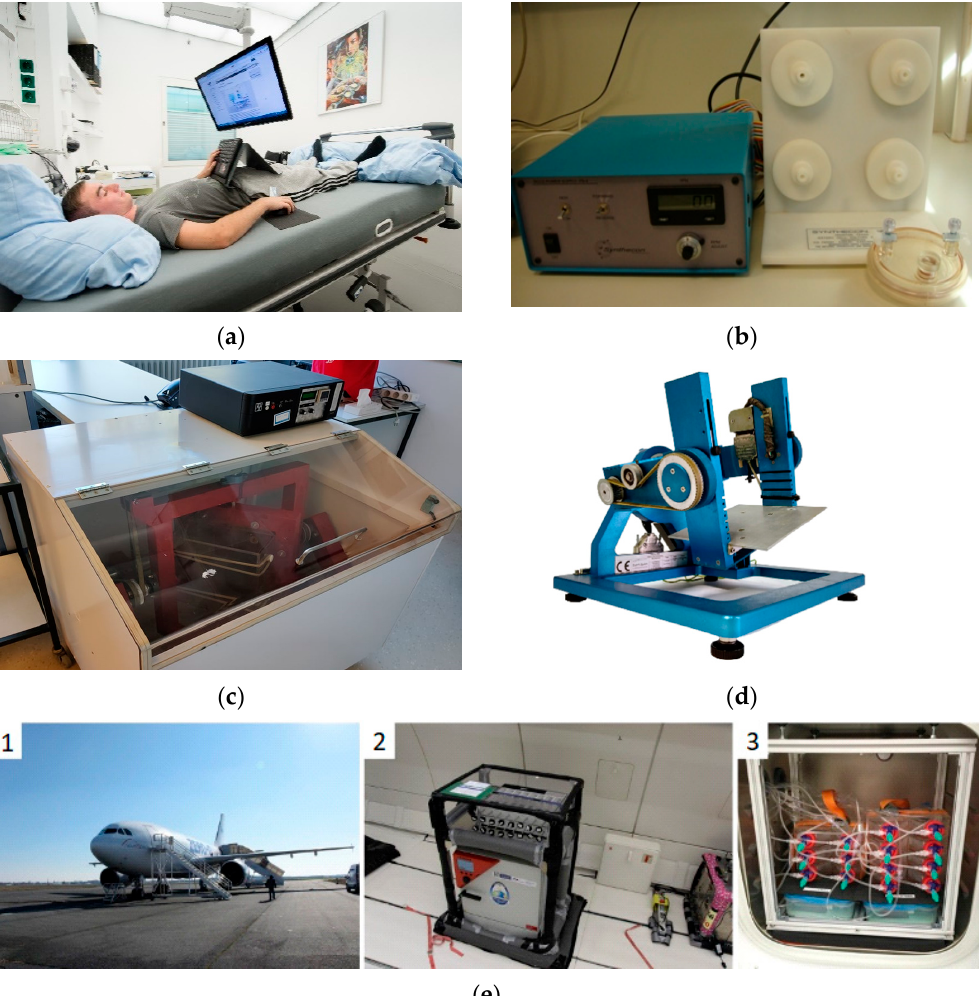
Figure 1. An overview of microgravity analogues. ( a ) The head-down bed rest experiment configura- tion (taken from the National Aeronautics and Space Administration (NASA) and Deutsches Zentrum für Luft-und Raumfahrt (DLR), CC BY-NC-ND 3.0 [56]); ( b ) a commercially available rotating wall vessel; ( c ) a commercially available three-dimensional clinostat; ( d ) a commercially available desktop random positioning machine; and ( e ) experimental setup for a parabolic flight, where image (1) shows the Airbus 310 aircraft used for the parabolic flight, picture (2) shows the incubator used for the experiment, and image (3) gives an impression of the inside of the incubator prior to take off of the flight. The images of ( e ) were published by Nassef et al. in